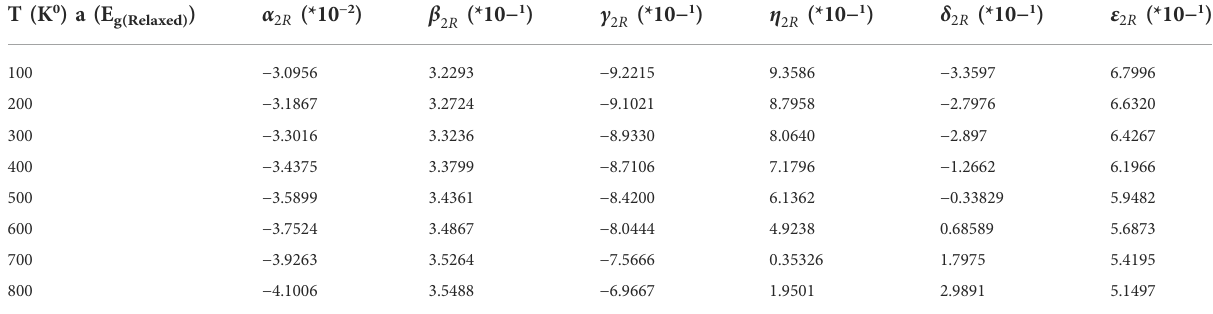
TABLE 6 Fitting parameters for “ a ” under the relaxed condition at different